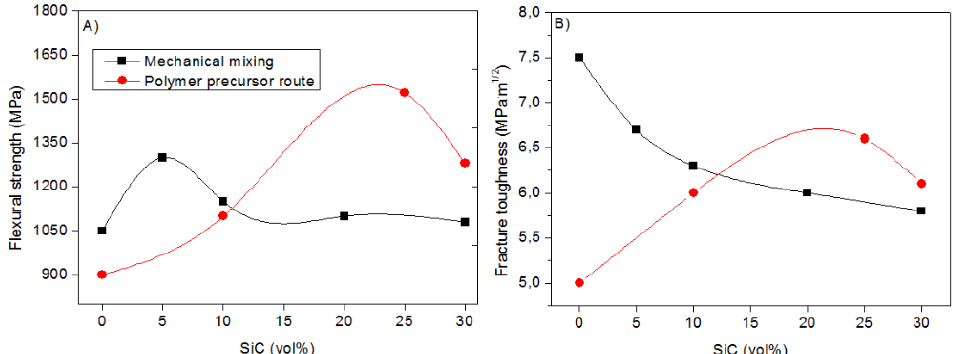
Figure 12. ( a ) Flexural strength and ( b ) fracture toughness of S 3 N 4 /SiC composite as a function of the SiC volume content. Black symbol: powder by conventional mixing and milling method [113]; red symbol: powder by polymer precursor route [114]. Redrafted from